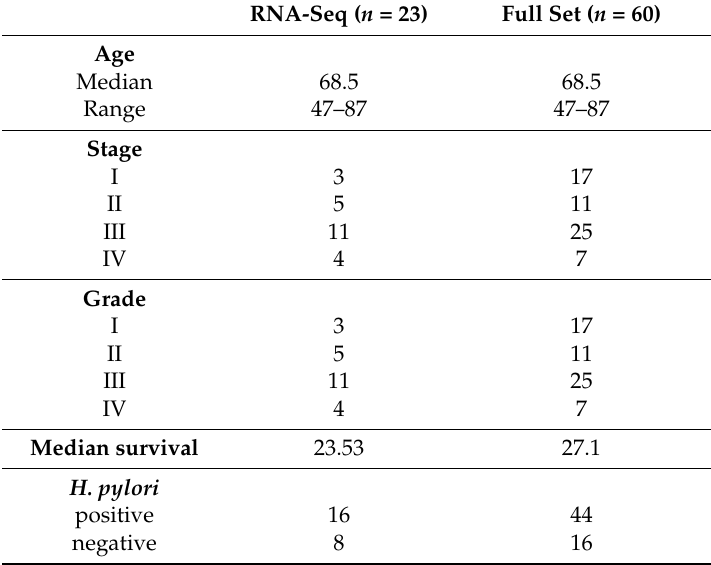
Table 2. Summary of clinico-pathological data for the gastric cancer patients in this